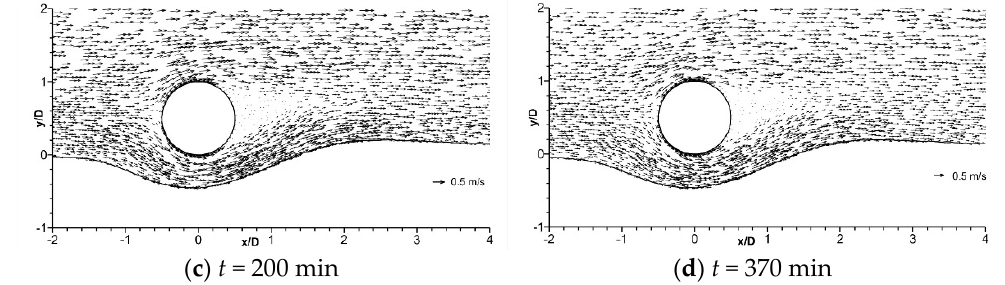
Figure 3. Snapshots of the flow field and bed profile around an infinitely long pipe.